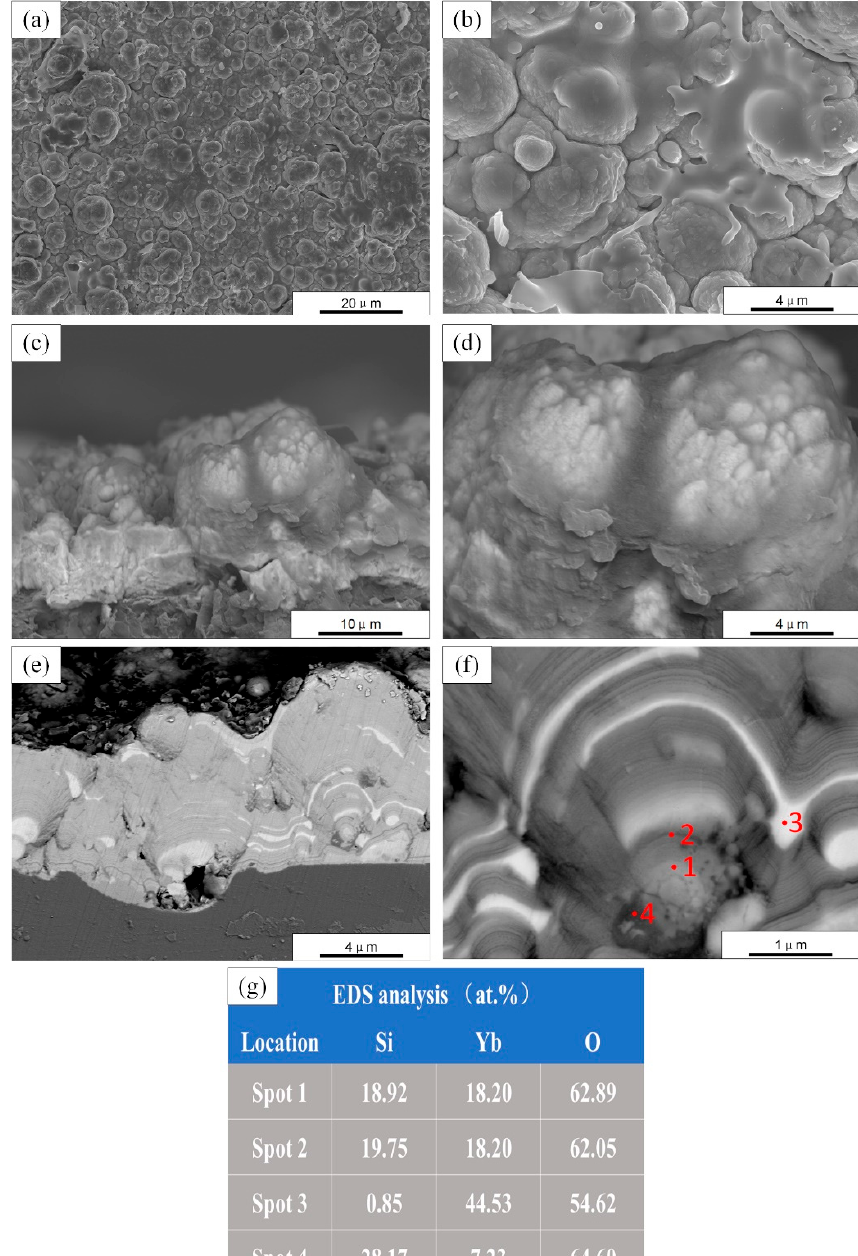
Figure 3. SEM micrographs of as-sprayed ytterbium silicate top-coats prepared by parameter set A: ( a , b ) Surface morphology; ( c , d ) Fracture morphology; ( e , f ) Cross section by back-scattered electron; and ( g ) EDS analysis of four spots in ( f ).